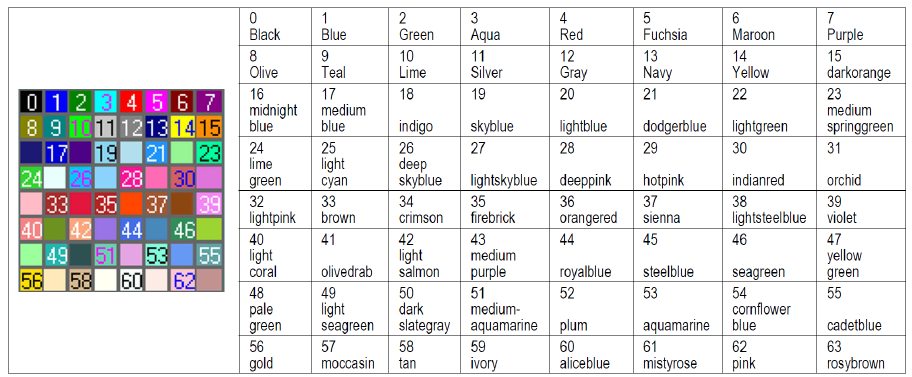
Figure 3. Color names for period- k components in M .